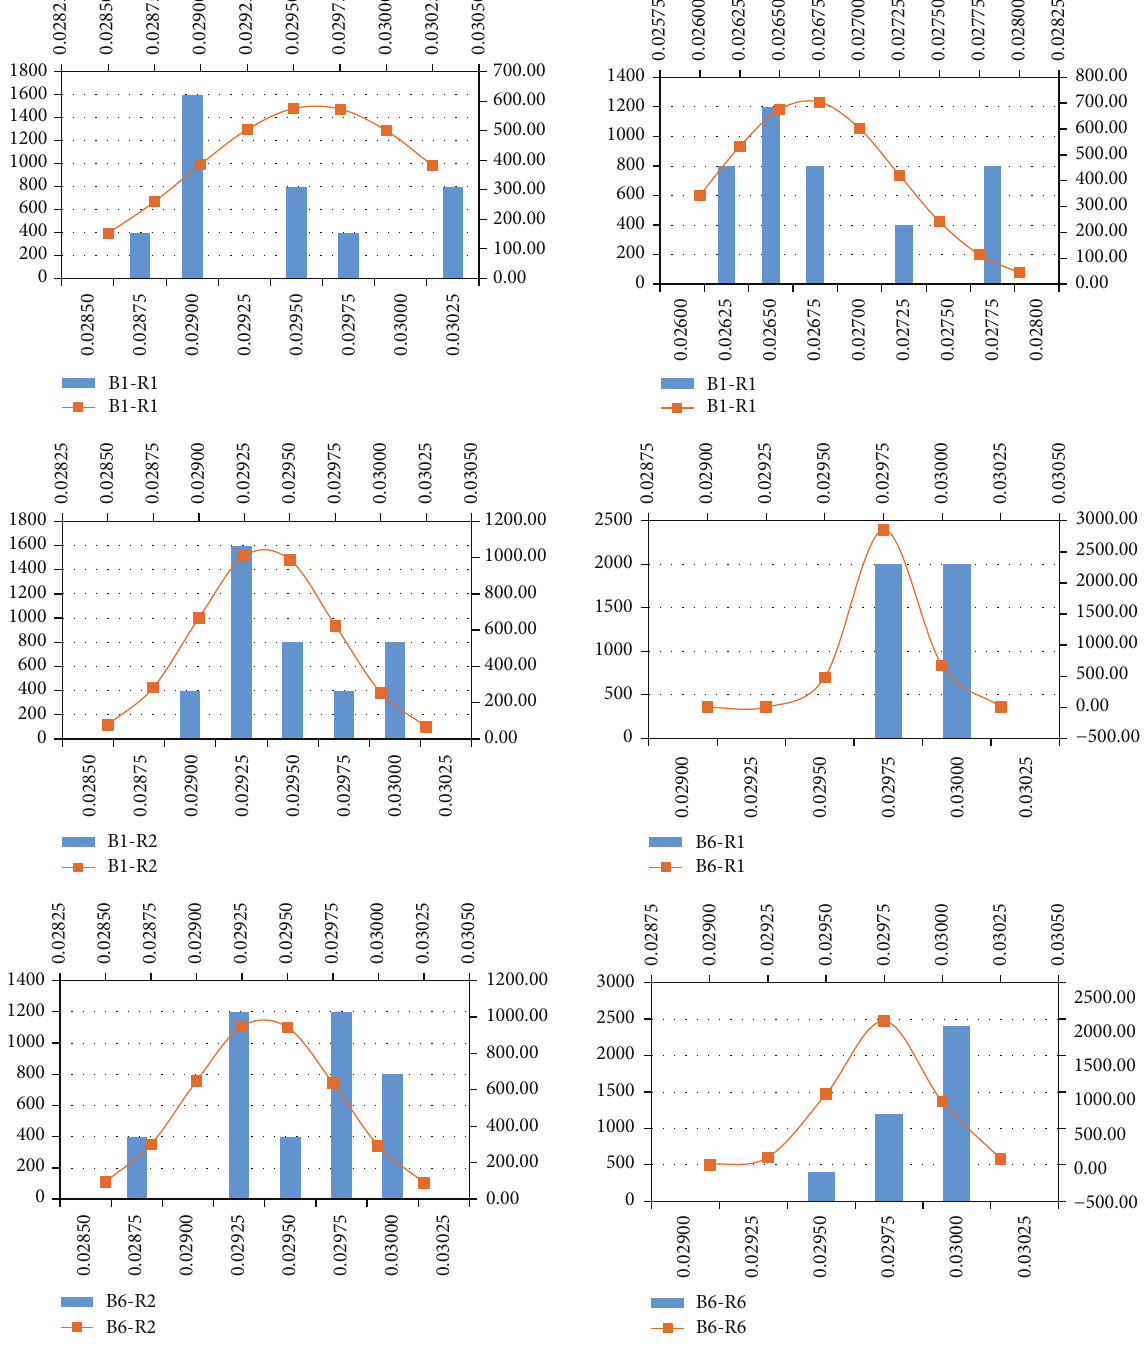
Figure 7: Probability of occurrence and density functions of bars’ diameters: longitudinal